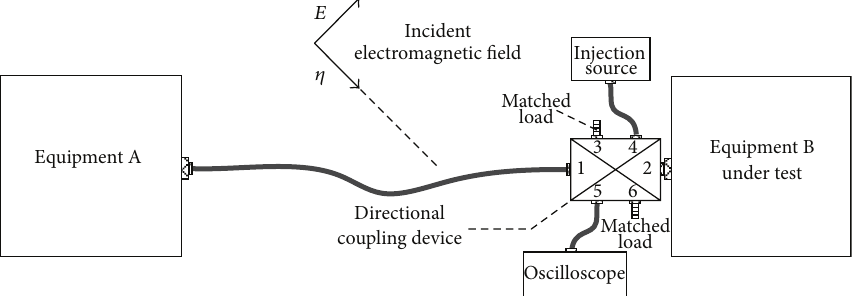
Figure 4: The sketch map of connection mode for DCD.